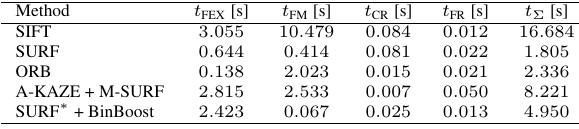
Table 2. Average processing times t FEX for feature extraction, t FM for feature matching, t CR for coarse registration, t FR for fine registration and average total time t Σ required for automatically aligning two scans.